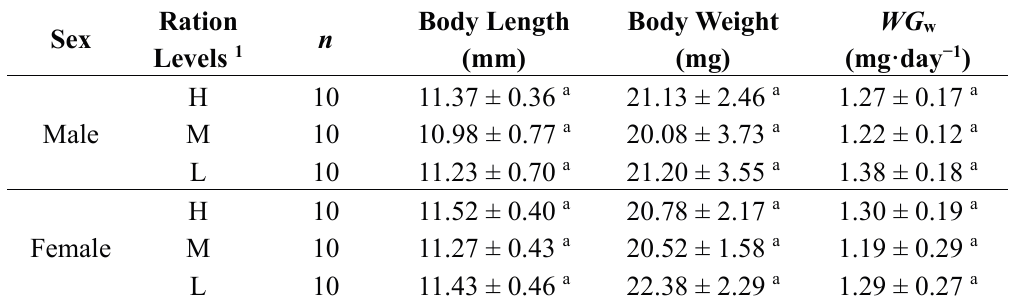
Table 3. The growth performances of the second-generation offspring from 0 to 11 days of age. Ration Sex Levels